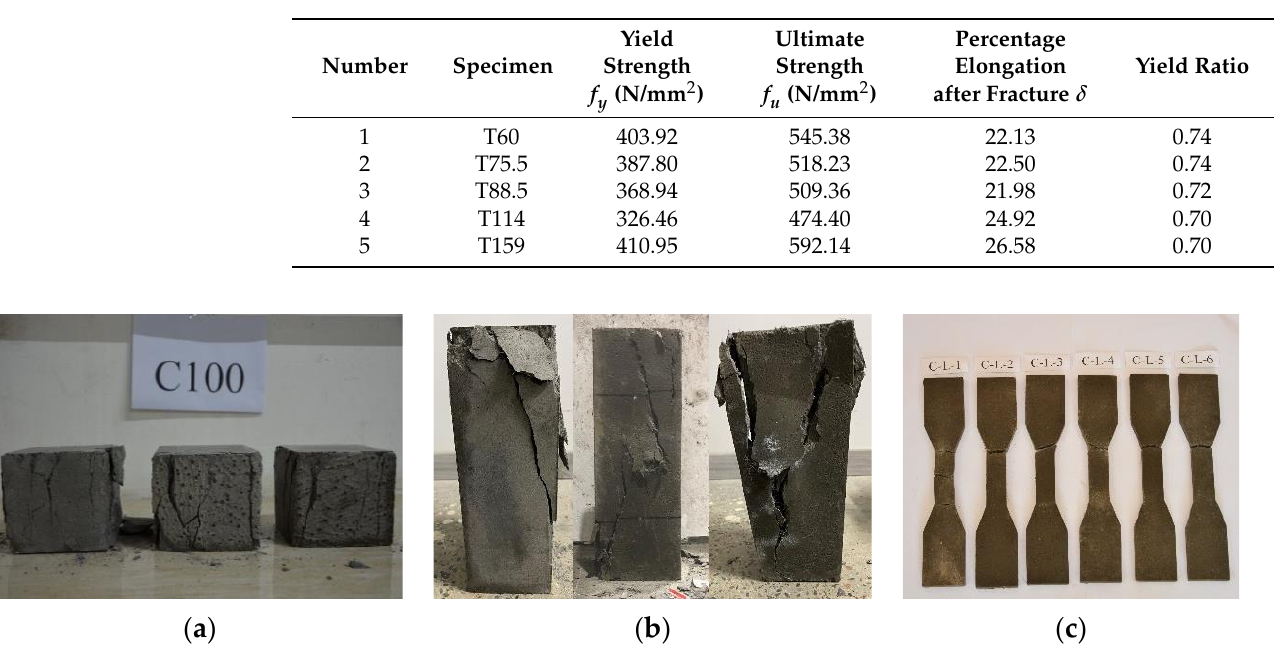
Table 2. Mechanical performance test results of steel pipes.